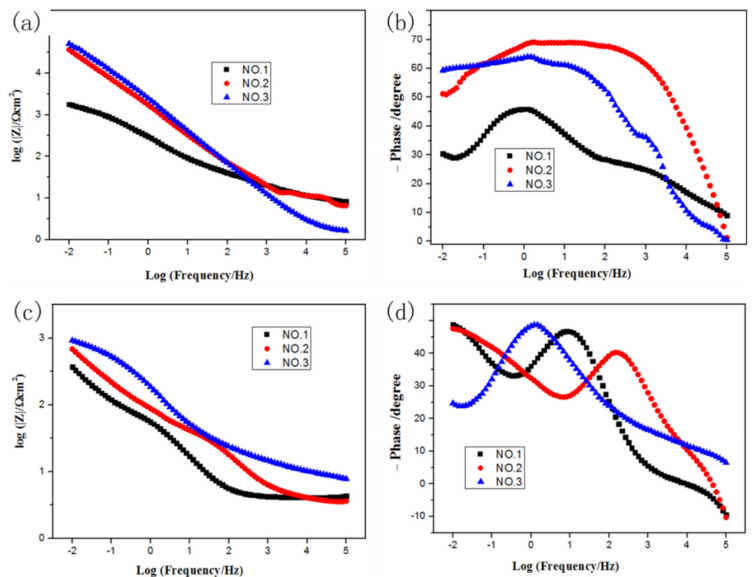
Figure 11. Bode plots recorded of the sample without BFT: ( a ) lg |Z|-lgf; ( b ) phase-lgf; Bode plots recorded of the sample after BFT: ( c ) lg|Z|-lgf ( d )